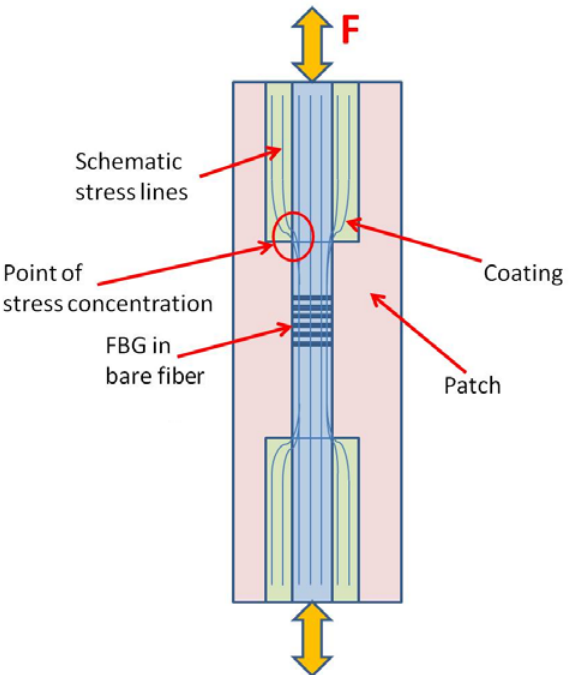
Figure 15. Schematic drawing of the stress concentrations of the embedded fiber inside a patch under dynamic loading